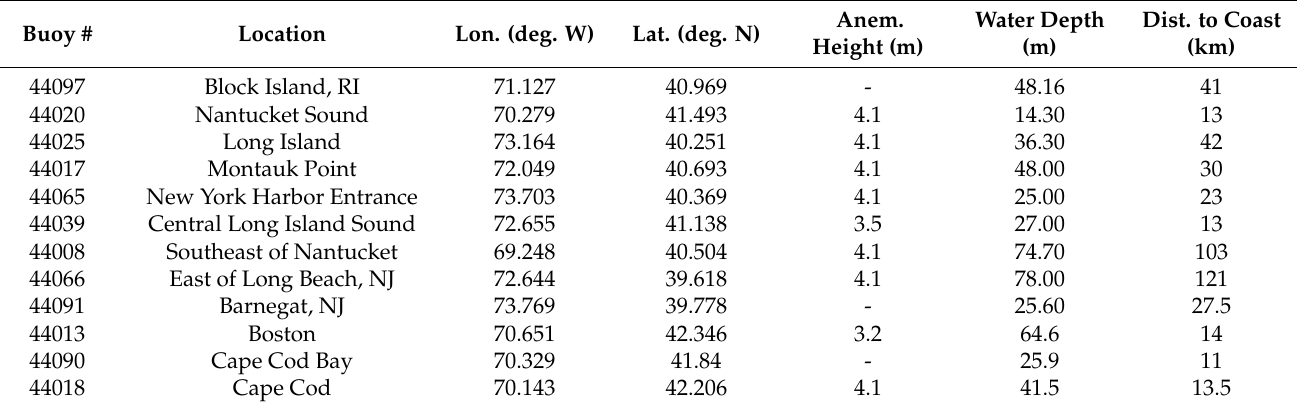
Table 2. The location, coordinates, anemometer height, water depth, and distance to the coast of the buoys used in this